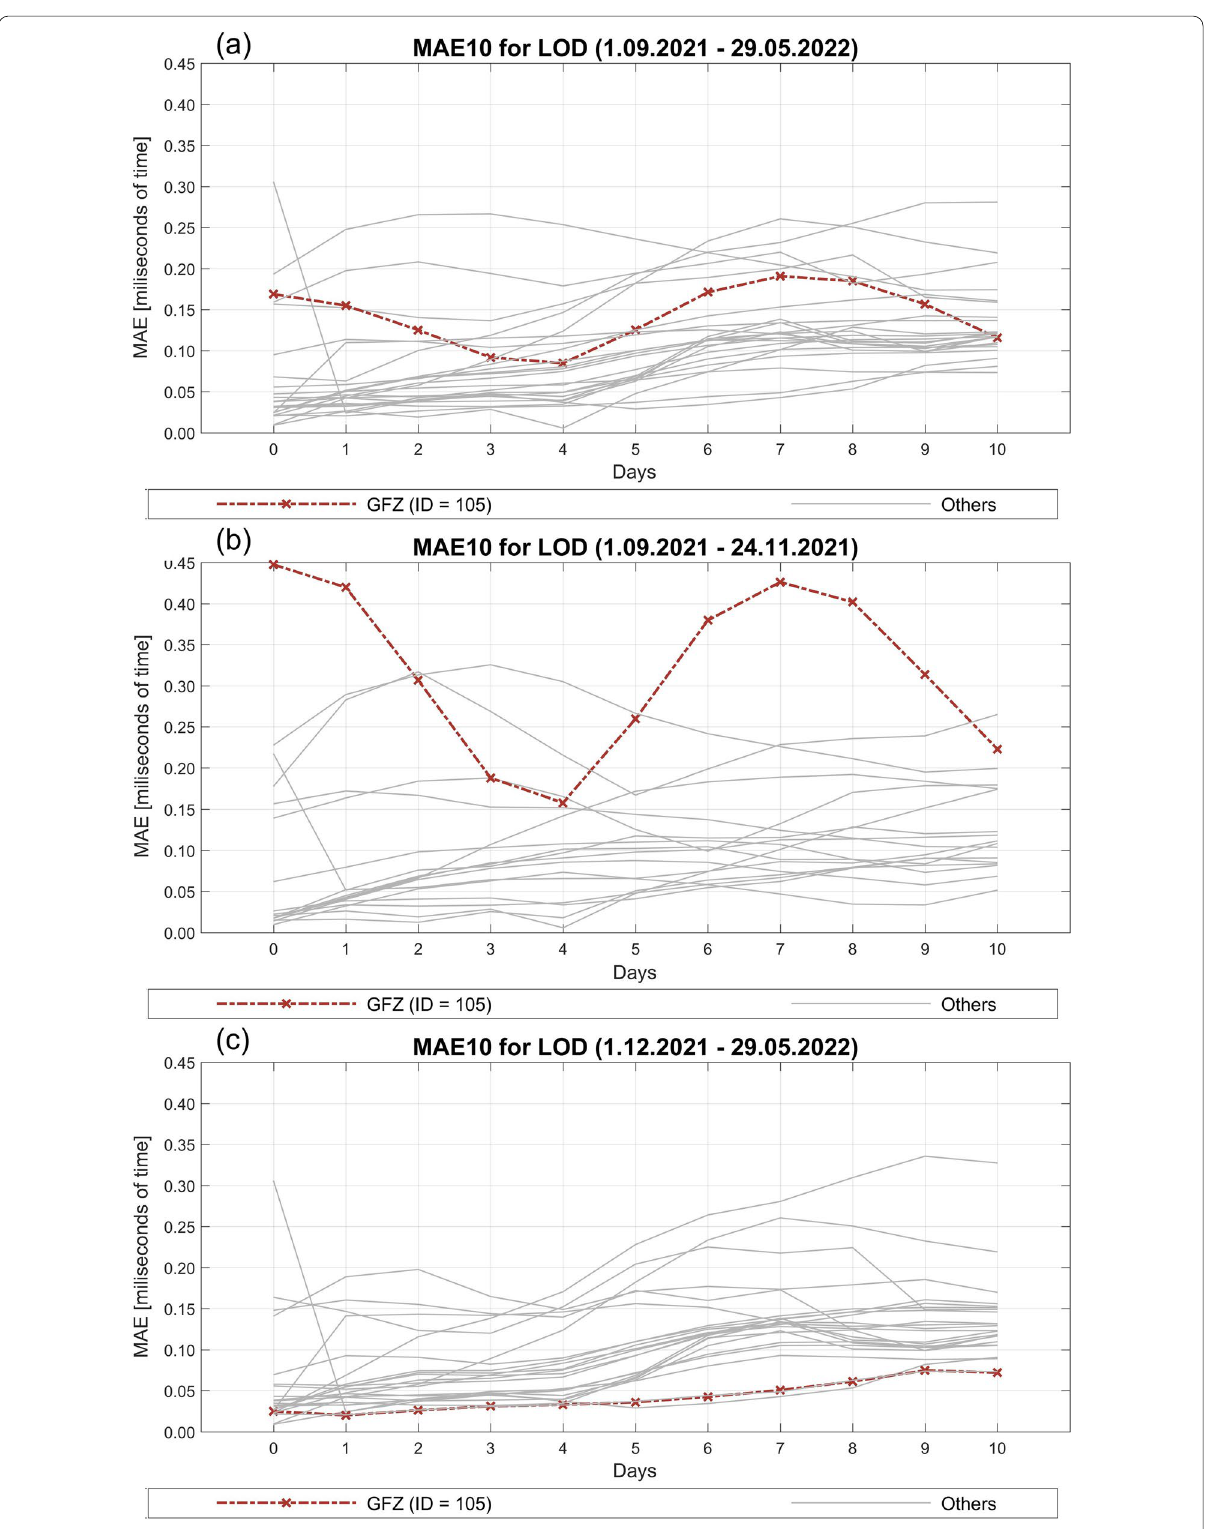
Fig. 2 Mean absolute error for LOD predictions from GFZ (ID 105) together with results for all other participants for forecast horizons between 0 = and 10 days: a calculated for a period between September 1st 2021 and May 29th, 2022, b calculated for a limited period between September 1st and December 1 st , 2021, and c calculated for a limited period between December 1st, 2021 and May 29th,